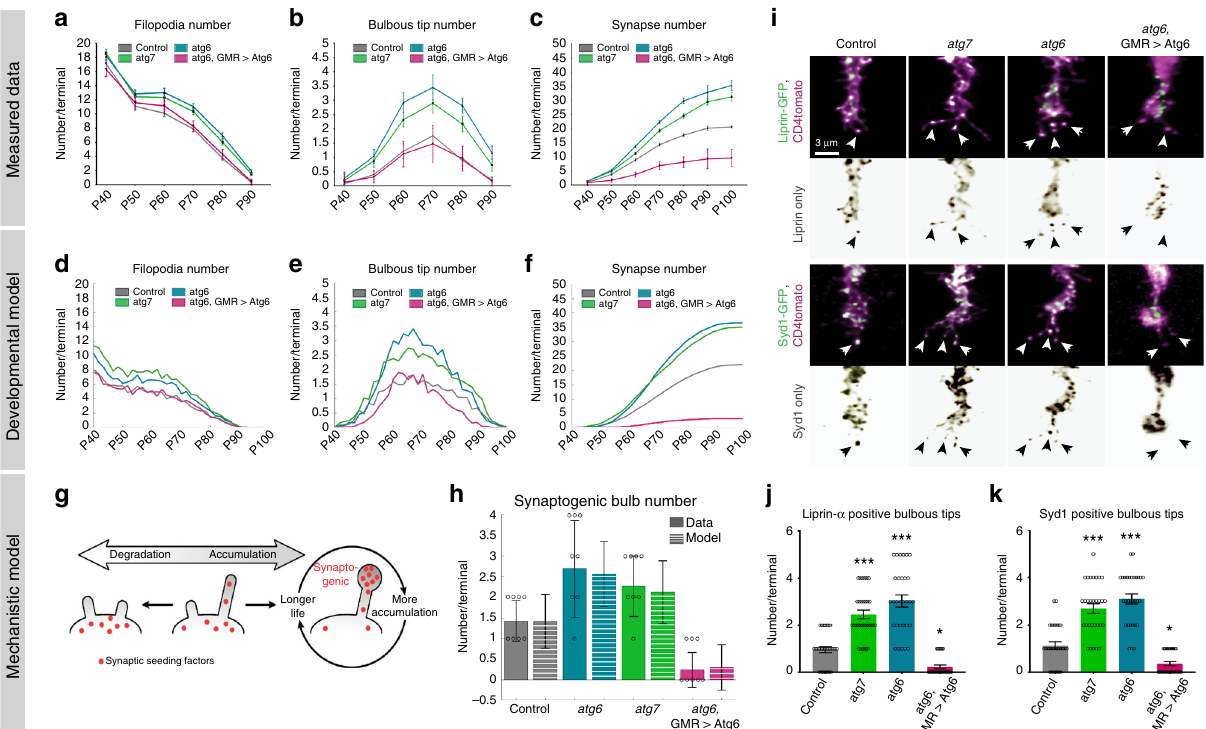
Fig. 6 Loss of autophagy increases the number of synaptogenic fi lopodia through defective synaptic seeding factor degradation, leading to increased synapse formation throughout development. a – c Quanti fi cation of fi lopodia numbers ( a ), synaptogenic fi lopodia numbers ( b ), and Brp puncta numbers ( c ) during synaptogenesis (P40 – P90) per R7 axon terminal based on fi xed data. n = 40 terminals per condition. d – f Markov State Model simulation based on data in ( a ) and live data at P + 60% (Fig. 5) for fi lopodia numbers ( d ), synaptogenic fi lopodia numbers ( e ), and Brp puncta numbers per R7 axon terminal ( f ). g The mechanistic model: accumulation of synaptic seeding factors stabilizes synaptogenic fi lopodia; autophagic degradation of synaptic seeding factors destabilizes fi lopodia. h Measured (solid bars) and simulated (striped bars) synaptogenic fi lopodia numbers at P + 60% (the simulated data are based on synaptic seeding factor availability, see Supplementary Fig. 6). n = 8 axon terminals from independent live-imaging sessions. i Representative images of synaptic seeding factors (Syd-1 and Liprin- α ) localizing to synaptogenic fi lopodia. Repeated three times independently with similar results. j , k Quanti fi cations of the number of Liprin- α ( j ) and Syd-1 ( k ) positive synaptogenic fi lopodia. n = 30 terminals per condition. Kruskal – Wallis and Dunn ’ s as post-hoc test; * p < 0.05, *** p < 0.001. Error bars denote mean ± SEM. Source data are provided as a Source Data fi increase fi lopodia lifetime, which in turn increases the time available for further accumulation of synaptic seeding factors, creating a positive feedback loop 14 . If autophagy plays a role in the degradation of synaptic seeding factors, then decreased autophagic degradation of synaptic seeding factors should lead to more synaptogenic fi lopodia, whereas increased autophagic degradation should reduce synaptogenic fi lopodia through fur- ther restriction of the limiting resource (Fig. 6g and Supple- mentary Fig. 11a). The simulations show that the measured number of synaptogenic fi lopodia (Fig. 6h) and their lifetimes